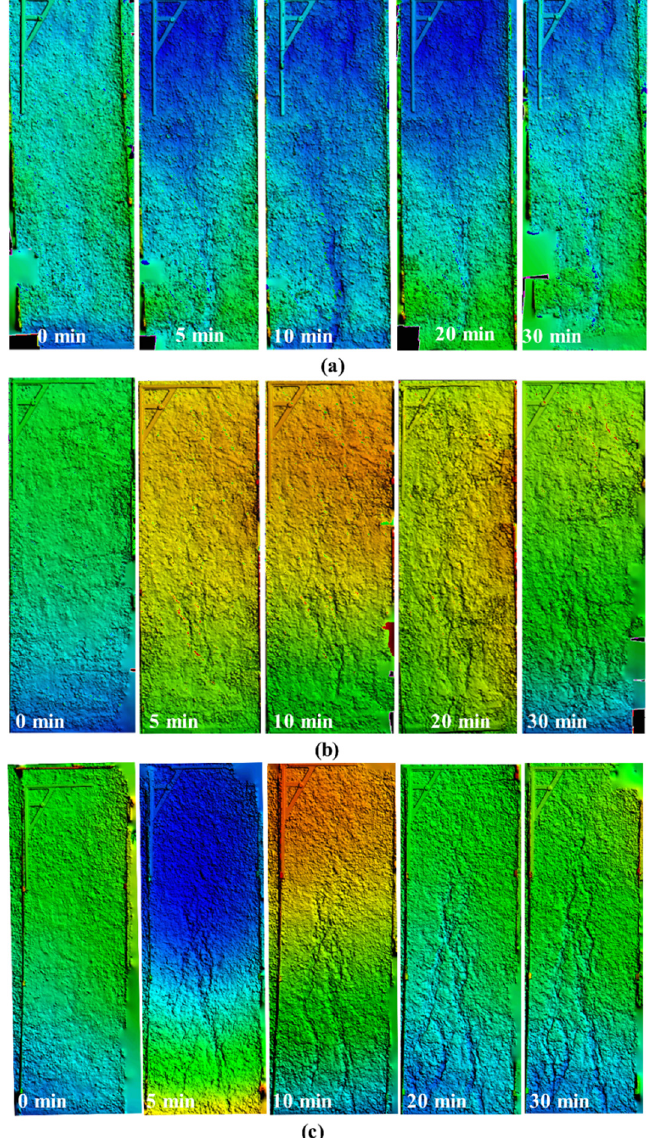
Figure 5. DEM map at fixed time under different slopes. ( a ) slope was 6°; ( b ) slope was 10° and ( c ) slope was 15°.